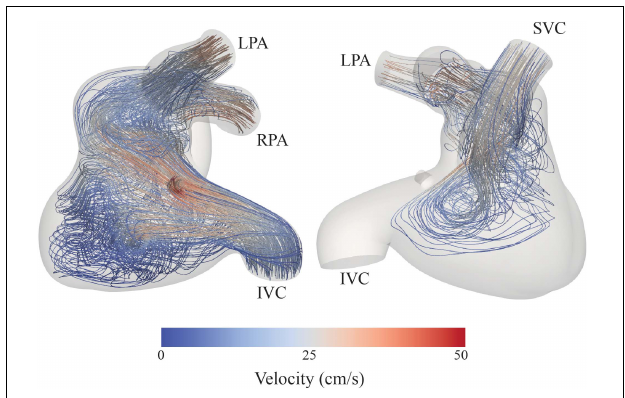
FIGURE 6 | Velocity streamlines depict swirling flow and low velocities in the dilated portion of the Fontan pathway.